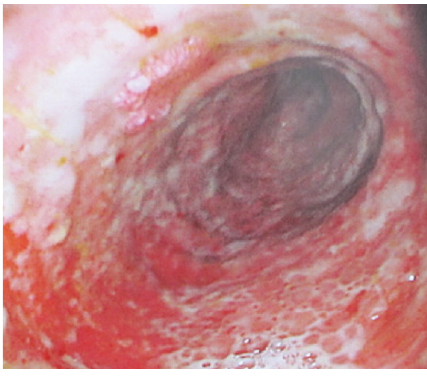
Figure 2: Macroscopic appearance of the bowel on endoscopy prior to right hemicolectomy in February 2016. This image demonstrates a severelycircumferentiallyulceratedtransplantileumconsistentwith severe